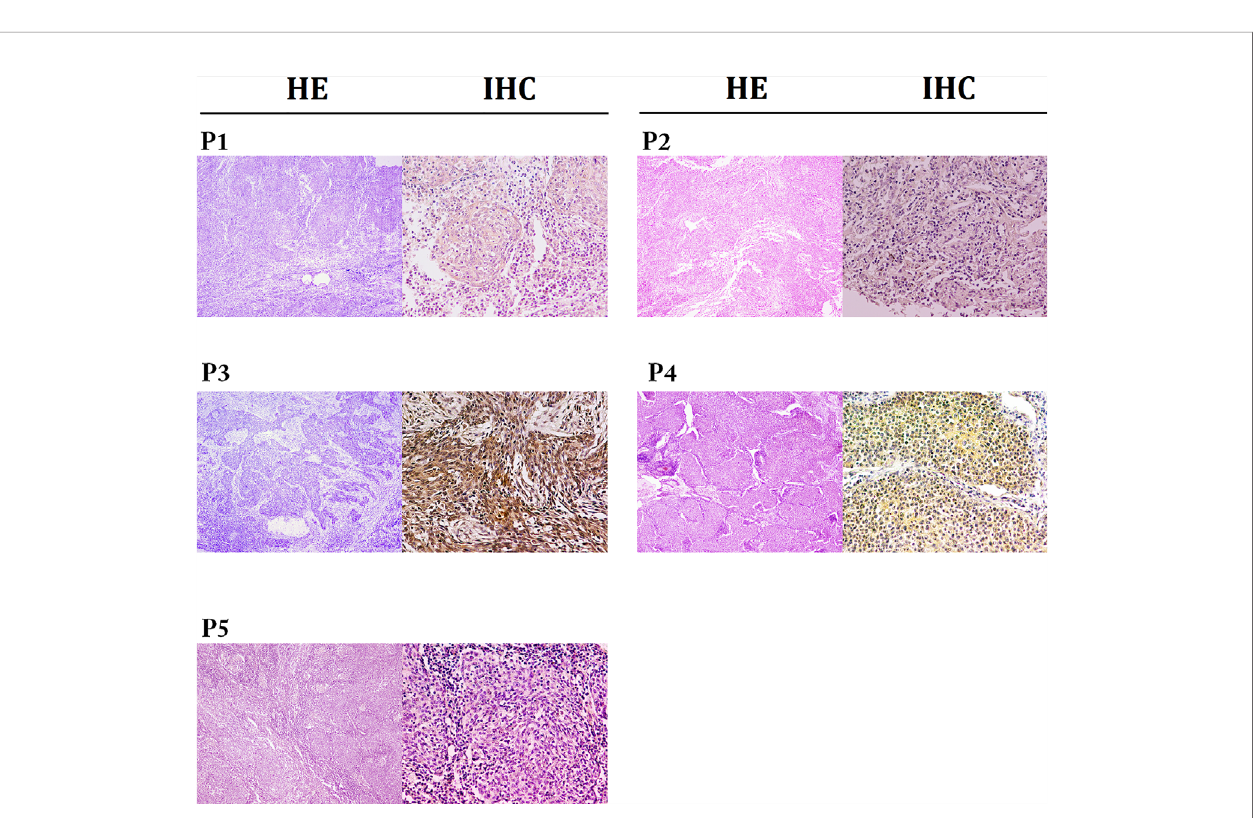
FIGURE 1 | Representative images for HE (×40) and IHC staining for PD-L1 expressions (×200). The expressions of PD-L1 in patients 1 to 5 were 40%, 30%, 90%, 80% and 5%,